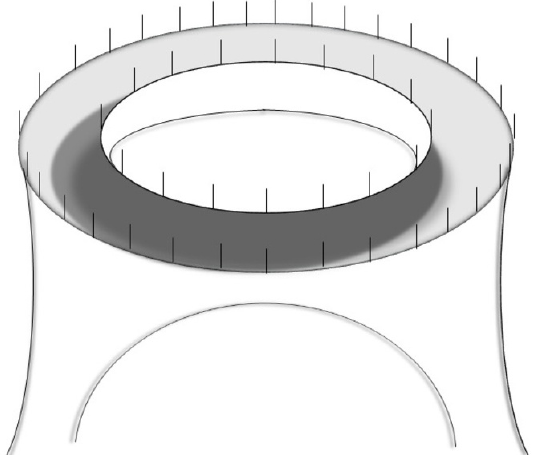
Figure 13 . Topologically di(cid:11)erent one obtained by making use of two cones in the manner described in main